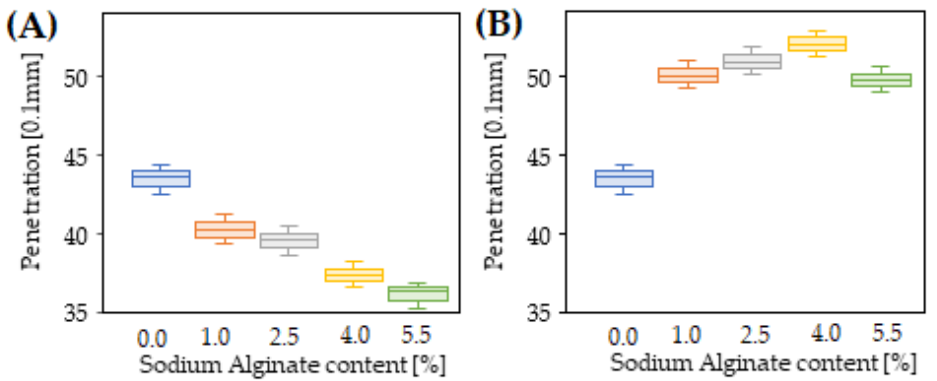
Figure 2. Penetration test results of 35/50 bitumen modified with sodium alginate ( A ) and 35/50 bitumen modified with sodium alginate in the presence of a crosslinking agent ( B ).